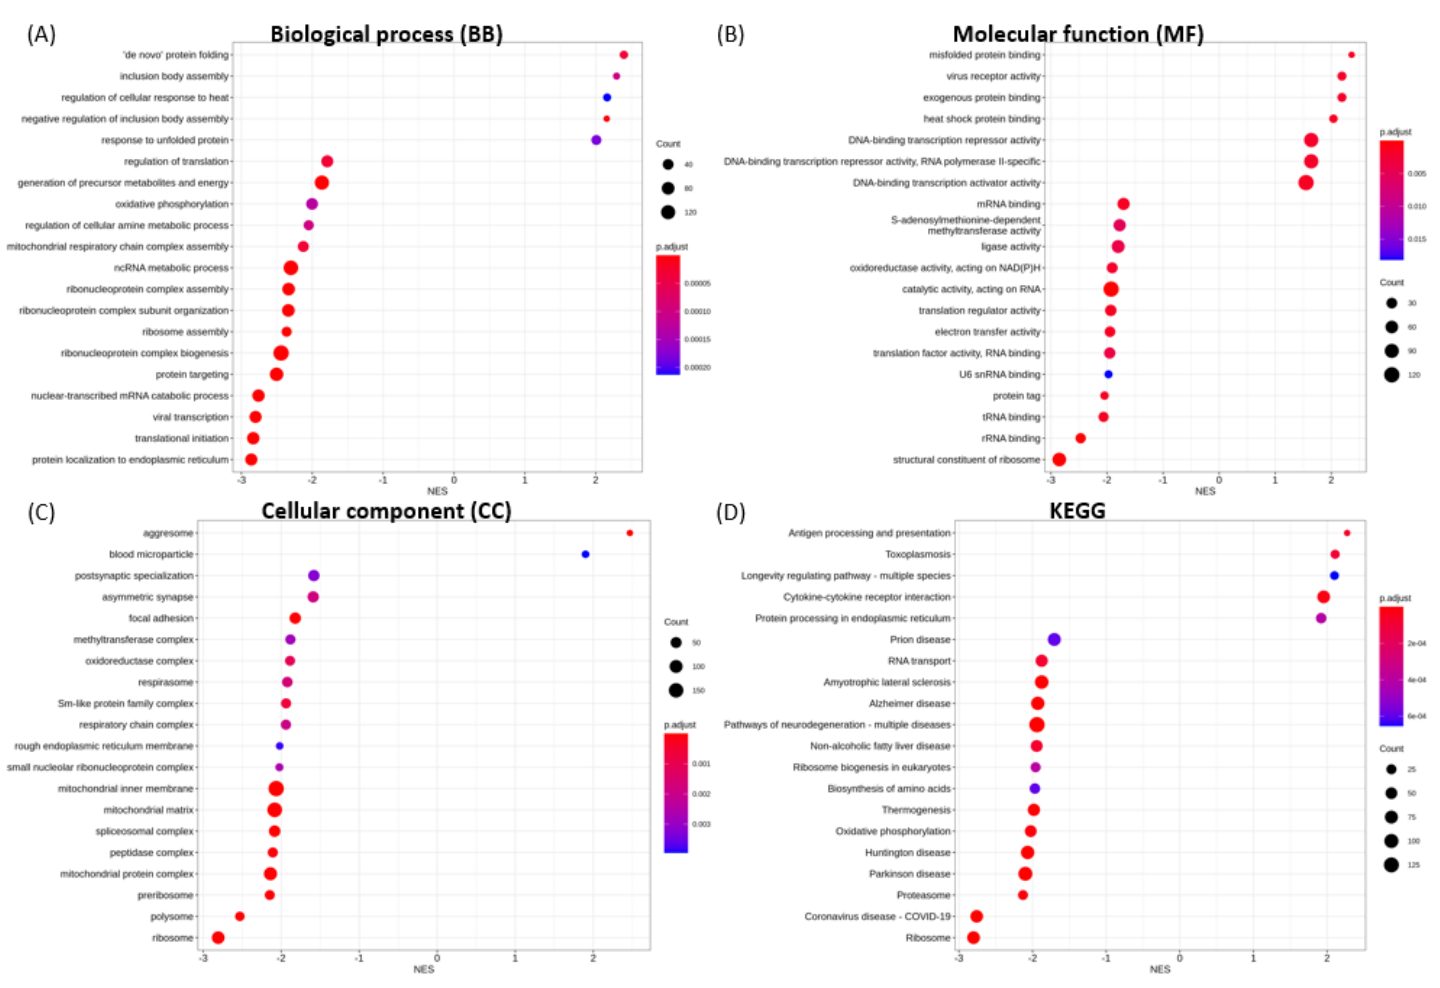
Figure 7. GSEA enrichment for SARS-CoV-2 NSP16 transfection illustrating the top 20 most significantly enriched terms for ( A ) BP, ( B ) MF, ( C ) CC and ( D ) KEGG pathways, in decreasing order based on normalized enrichment score